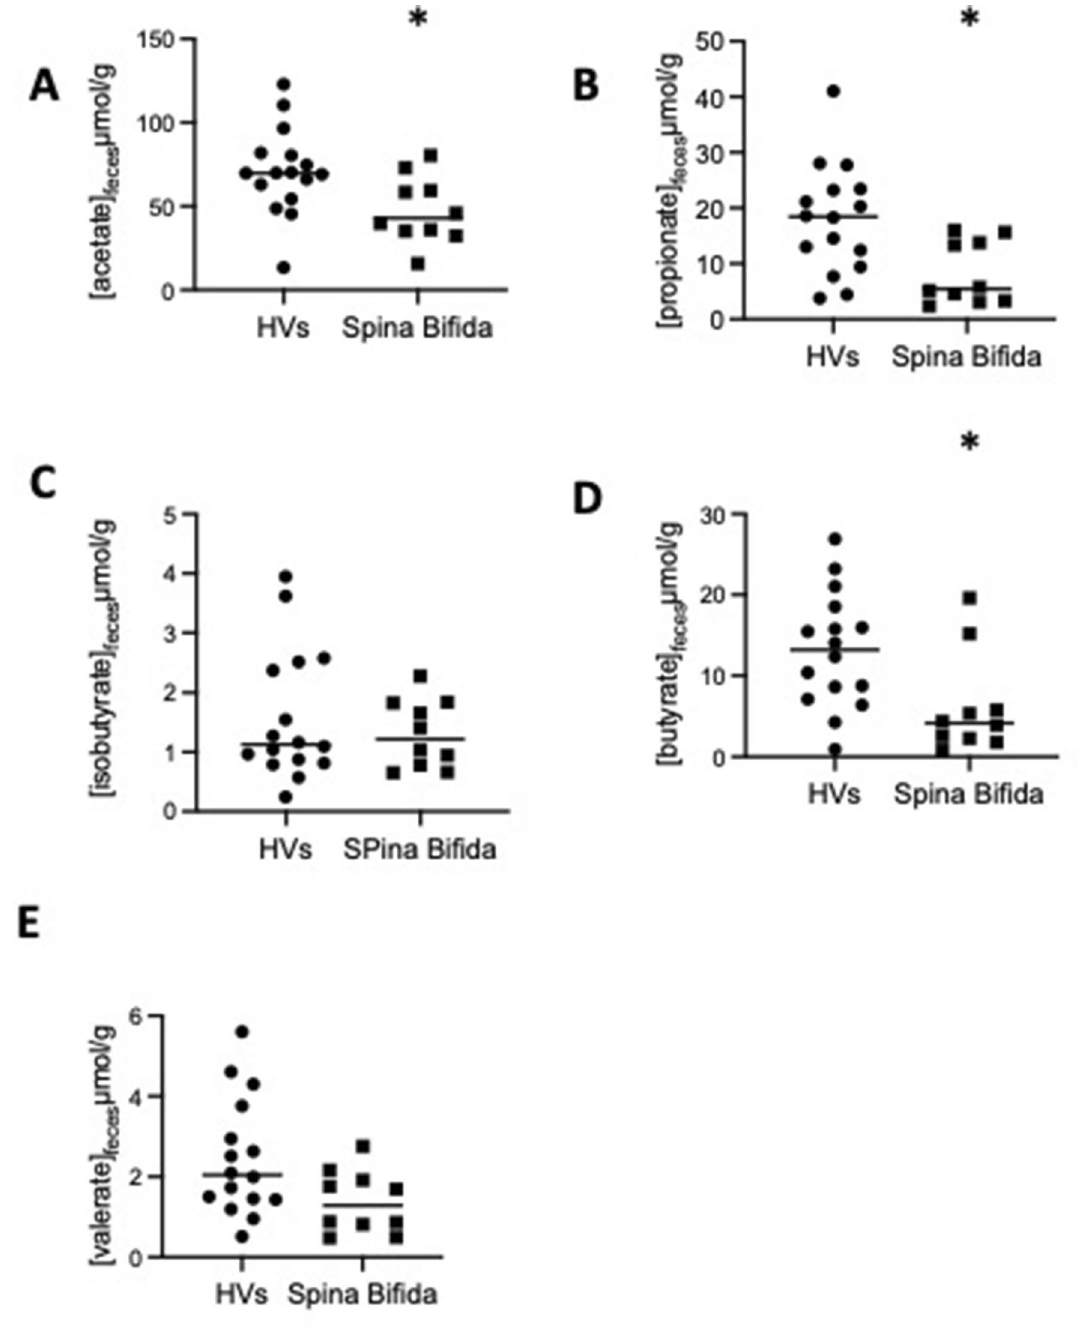
Figure 4. The expression levels of acetate, propionate and butyrate in fecal samples were significantly lower by 33, 54 and 53% in patients with SB compared with HVs (p = 0.02, p = 0.01, p = 0.02,